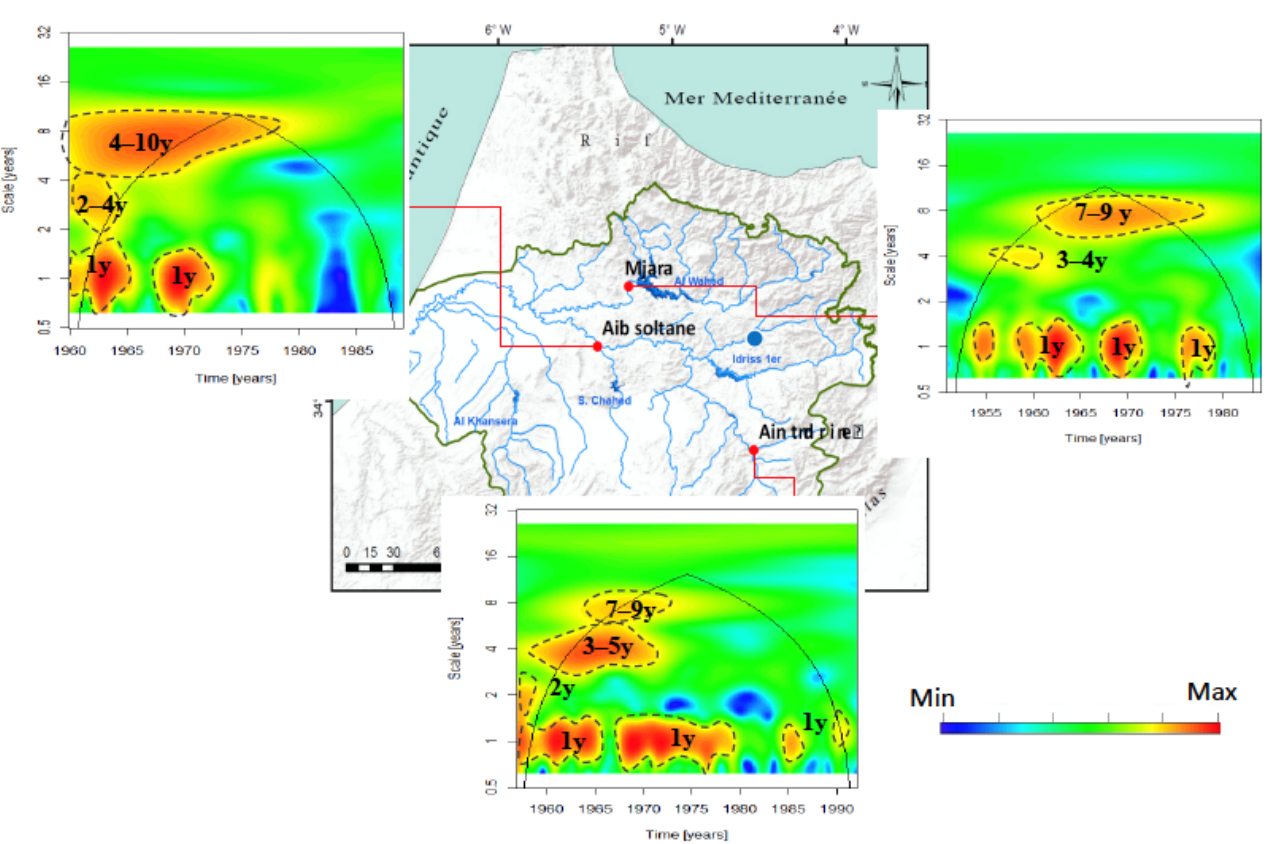
Figure 10. Study of hydrological variability in the Sebou basin.